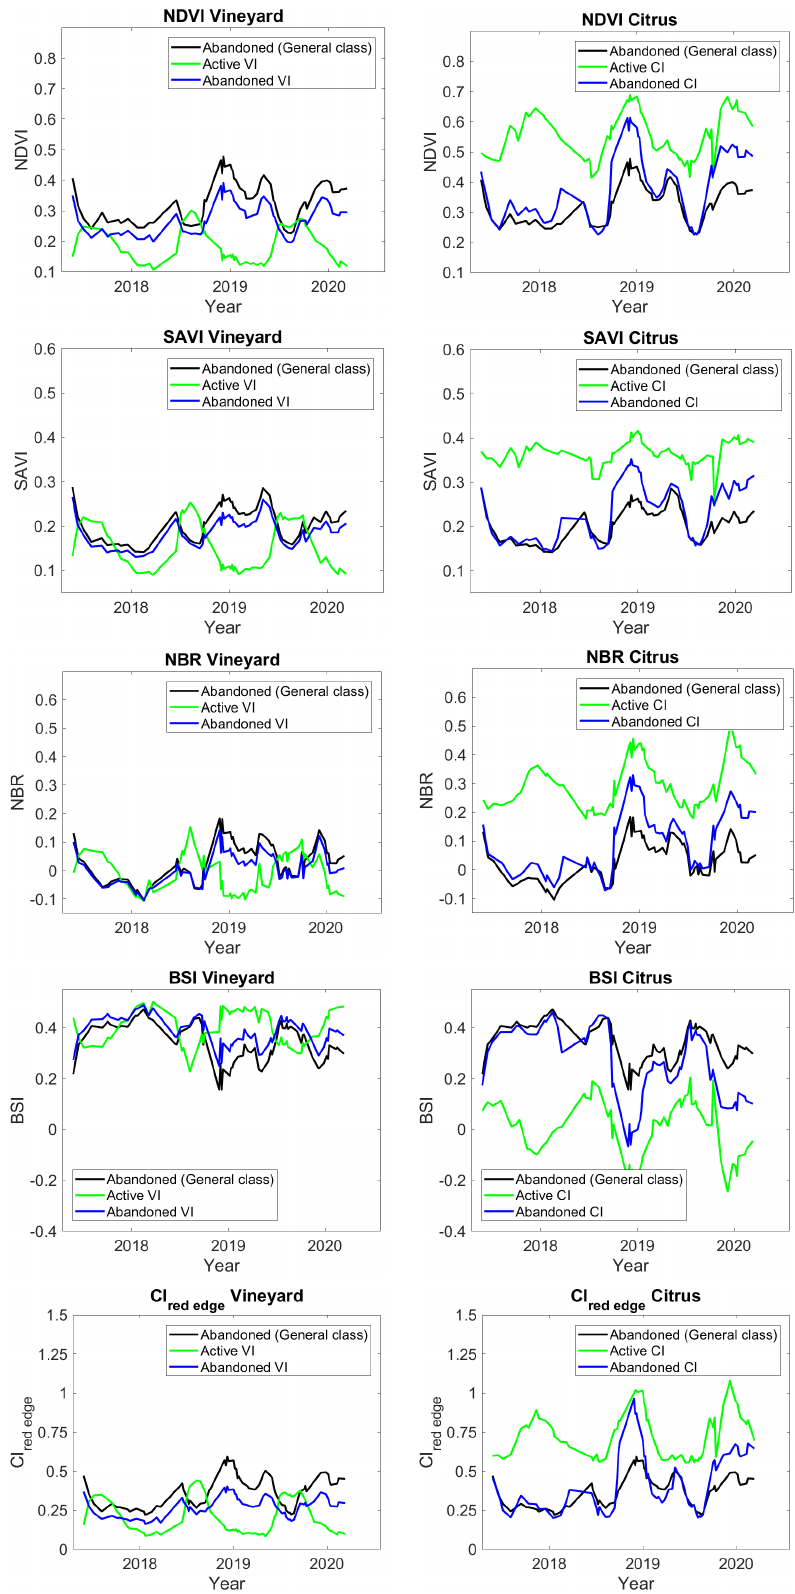
Figure 2. Temporal series of the five considered spectral indices, for the classes vineyards (VI) and citrus